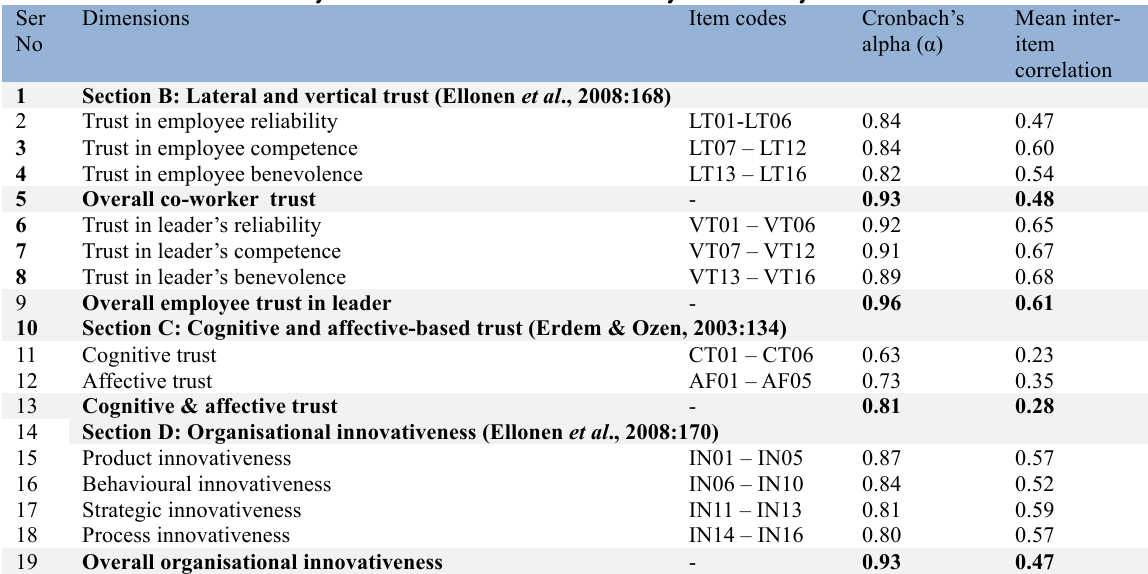
Table A1: Scale reliability for dimensions measured by the survey instrument